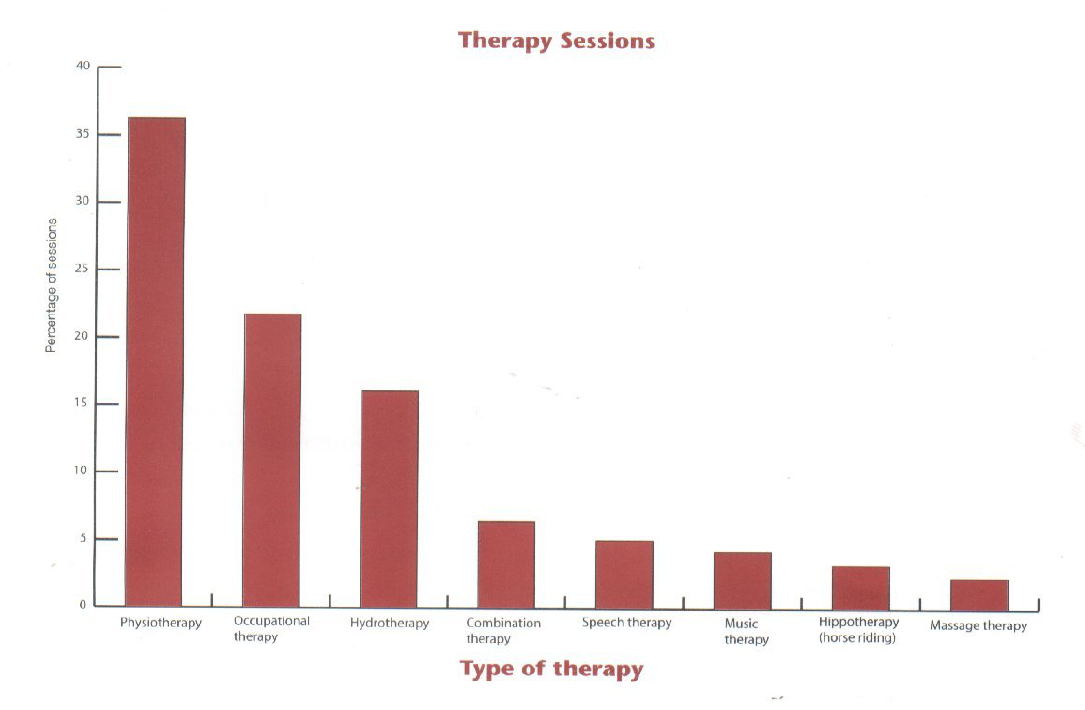
FIGURE 1. Therapeutic intervention for individuals with RS. Published with permission from